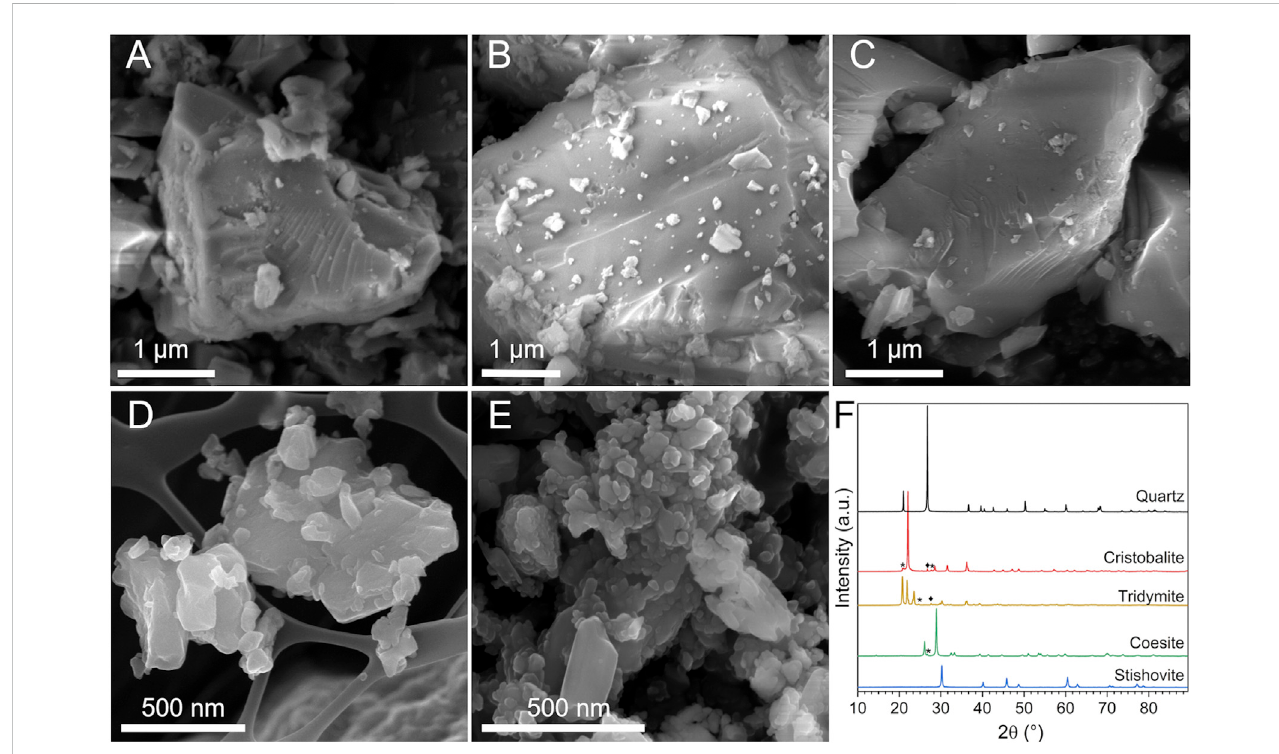
FIGURE 1 Morphology and crystallinity of the CS polymorphs. (A – E) Micrographs obtained by FESEM analysis: (A) quartz, (B) cristobalite, (C) tridymite, (D) coesite (background: grid of the stub), and (E) stishovite particles. (F) XRPD patterns of the CS polymorphs: ◆ quartz and *other contaminants.